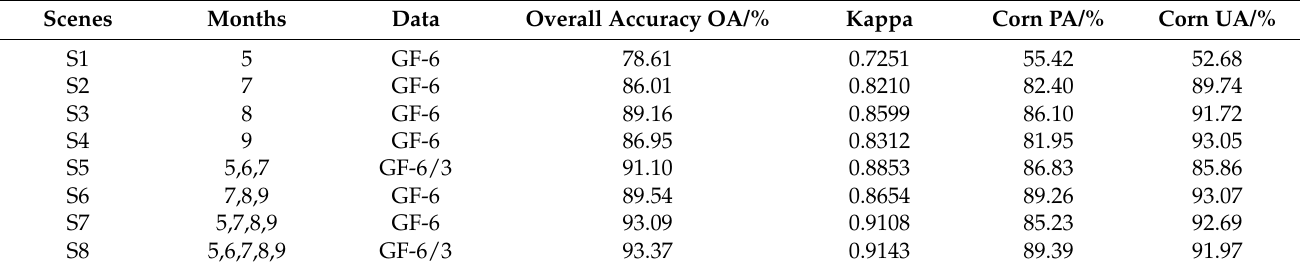
Table 5. Classification results at different growth stages based on GF3/GF6